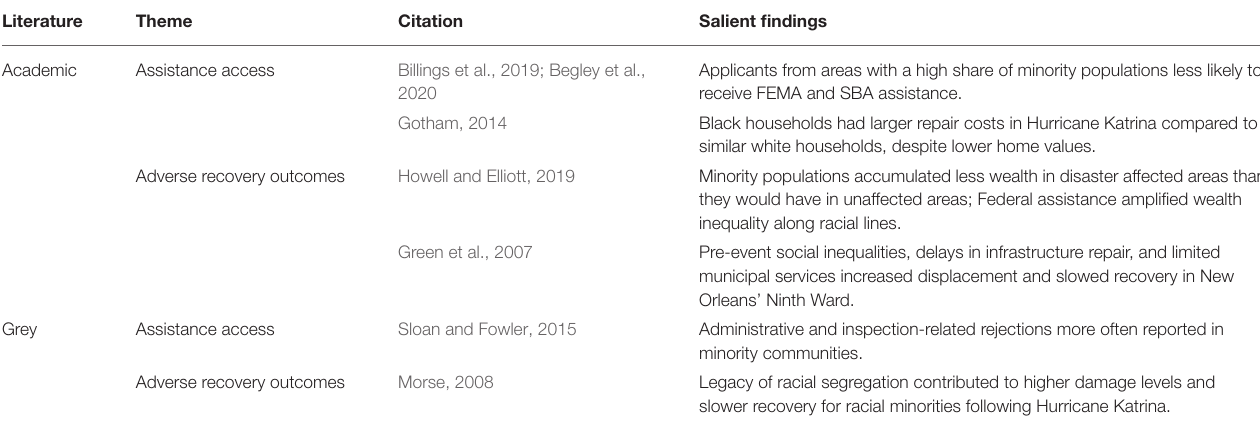
TABLE 4 | Key flood recovery studies focused on minority